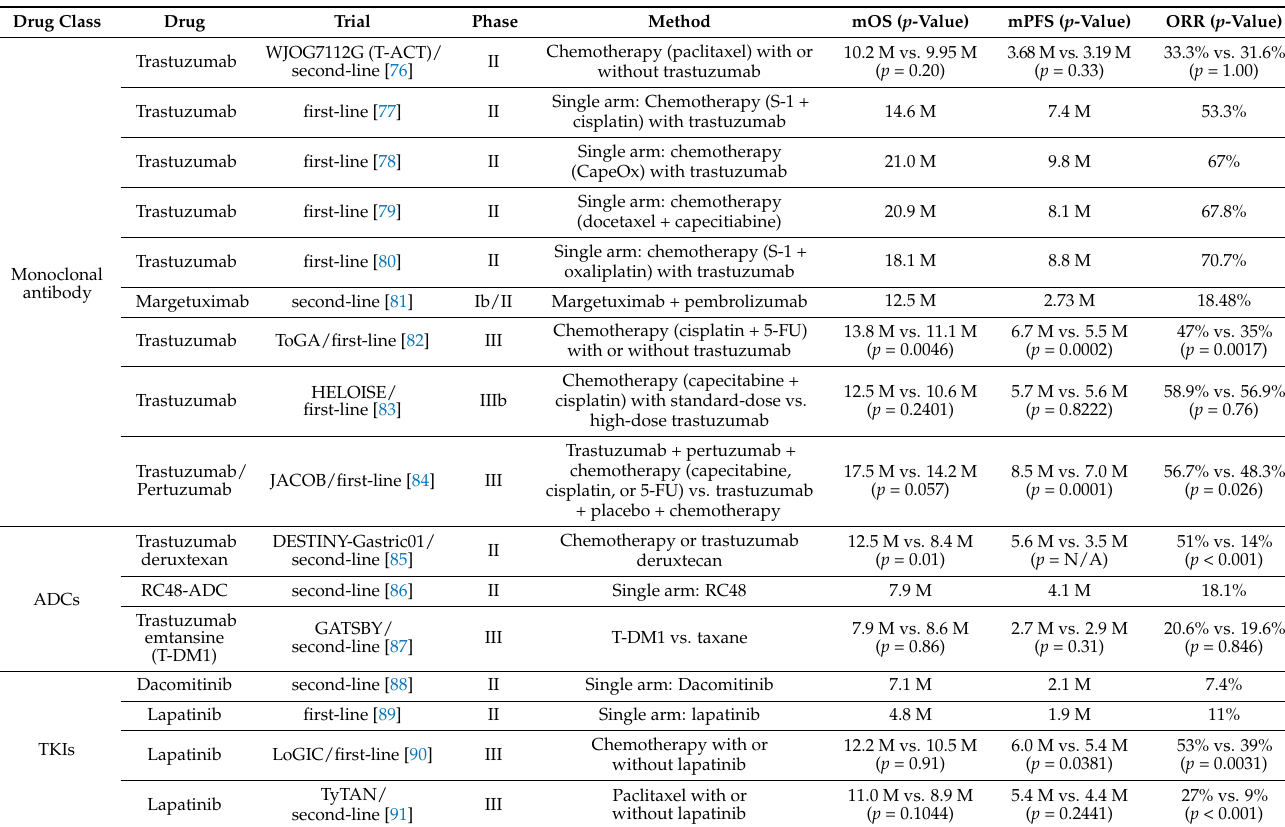
Table 2. Phase II and III trials of therapies targeting human epidermal receptor-2 (HER-2). mOS, median overall survival; mPFS, median progression-free survival; ORR, objective response rate; M, months; ADC, antibody–drug conjugate; TKI, tyrosine kinase inhibitor; CapeOx, capecitabine and